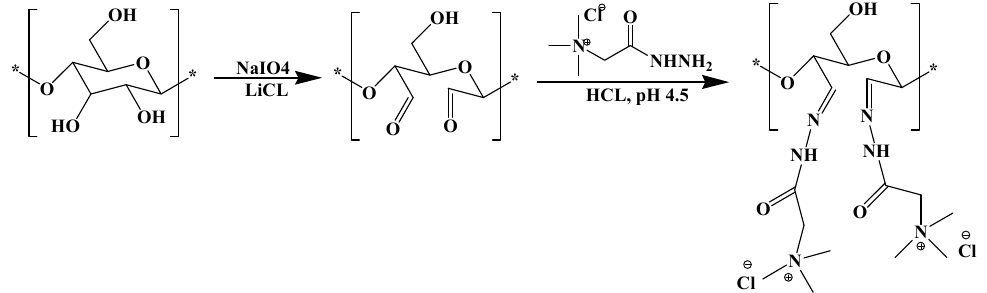
Figure 12. Two-step reaction scheme used to produce cationic cellulose (Taken from reference [77] with permission of the Royal Society of Chemistry).